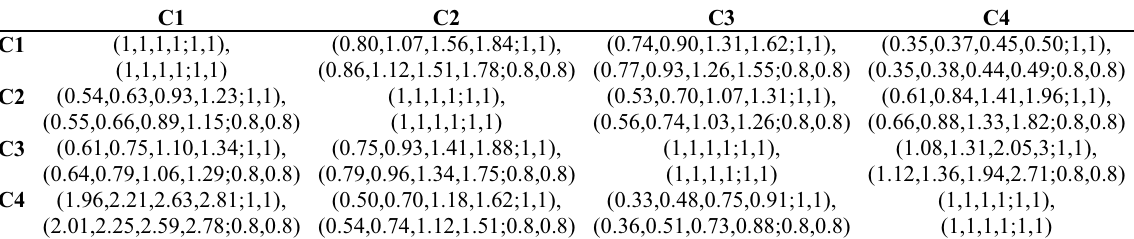
Table 6: Aggregated expert evaluations of criteria with respect to goal.